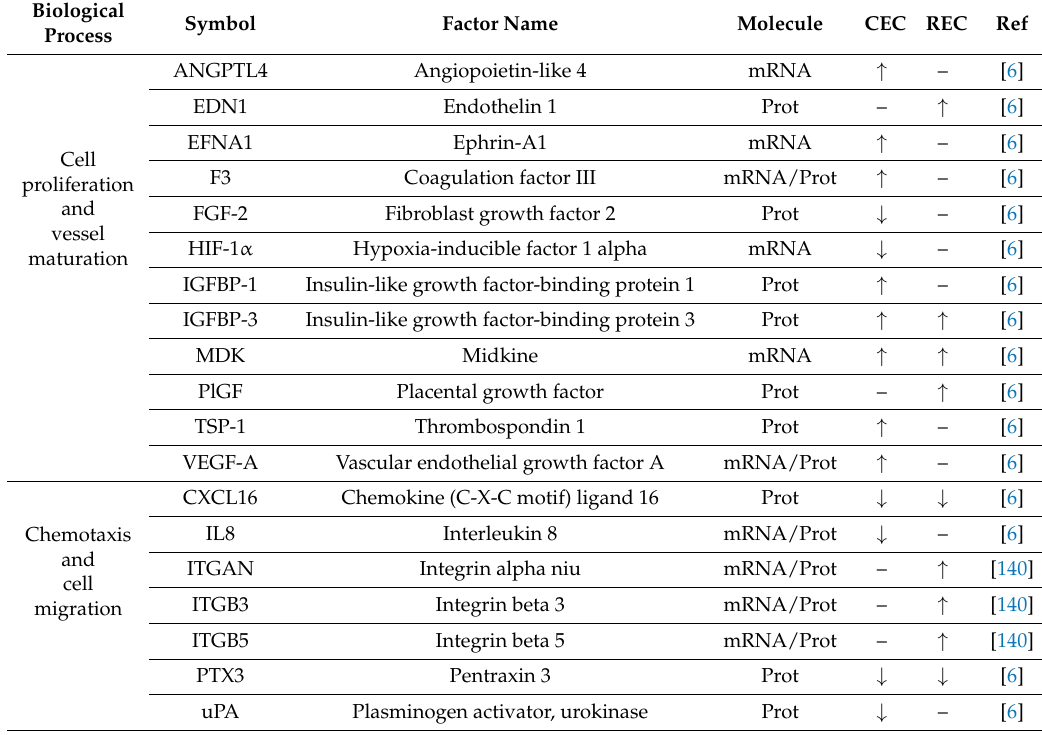
Table 2. Summary of angiogenesis-related factor regulation in REC and CEC in response to